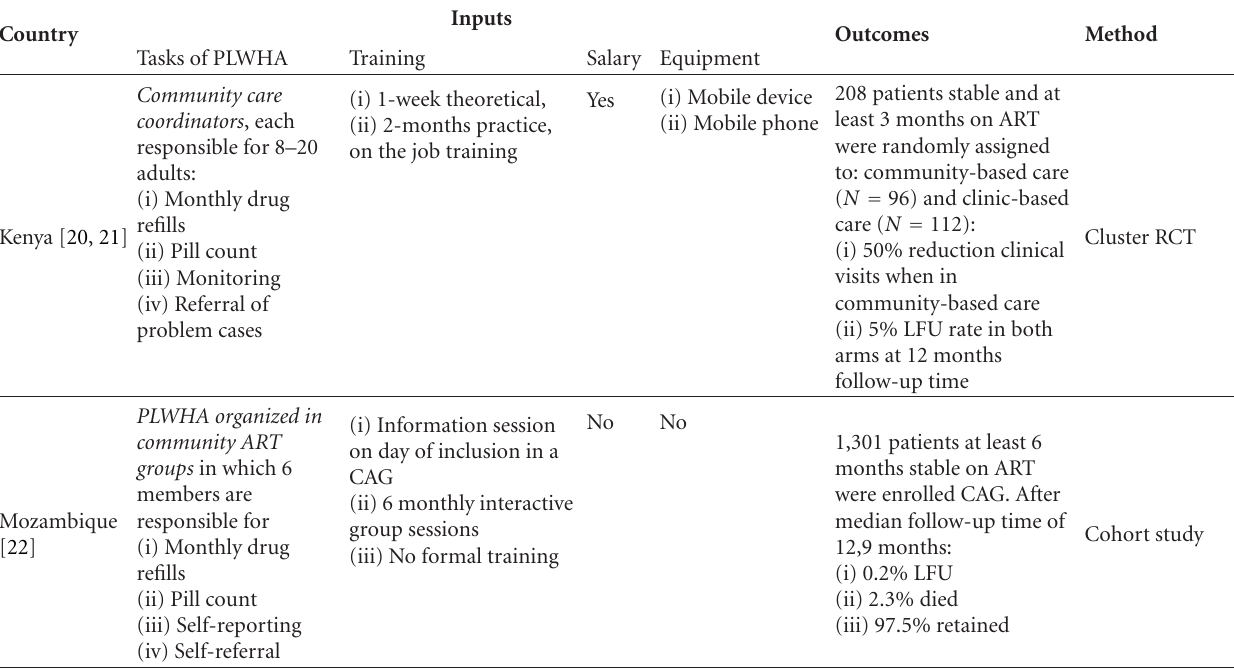
Table 1: Study characteristics of included